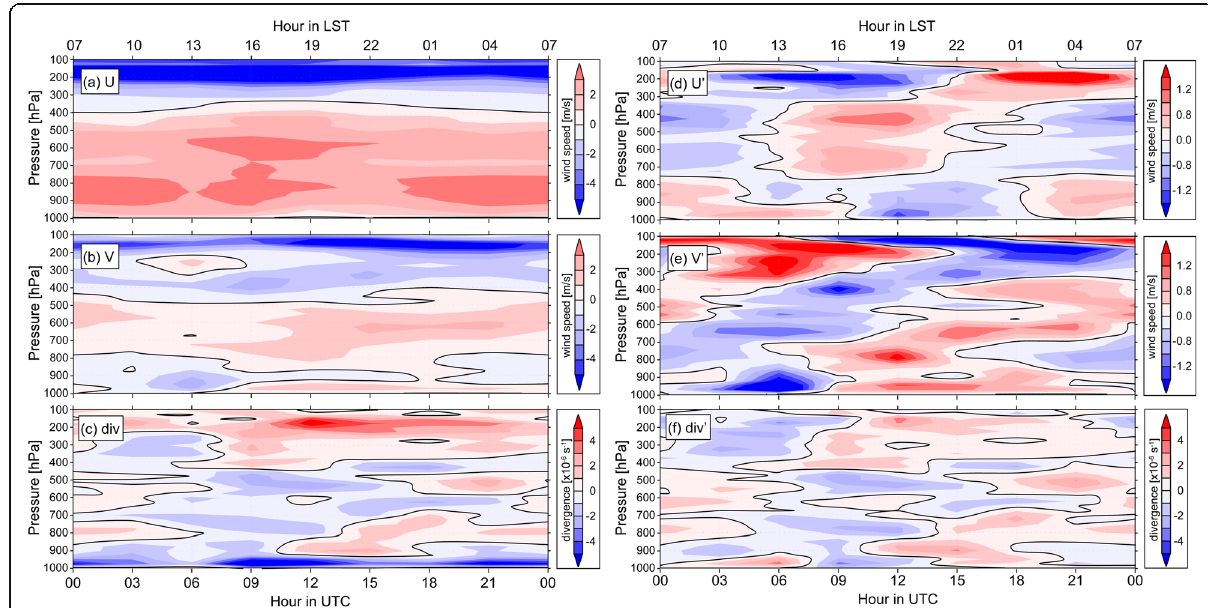
Fig. 7 Diurnal composite of the time – height cross section, for the zonal wind ( a , d ), meridional wind ( b , d ), and horizontal divergence ( c , f ); a to c are the composites of the absolute values, whereas d to f are the composites of the anomalies from the 1-day running mean at each pressure